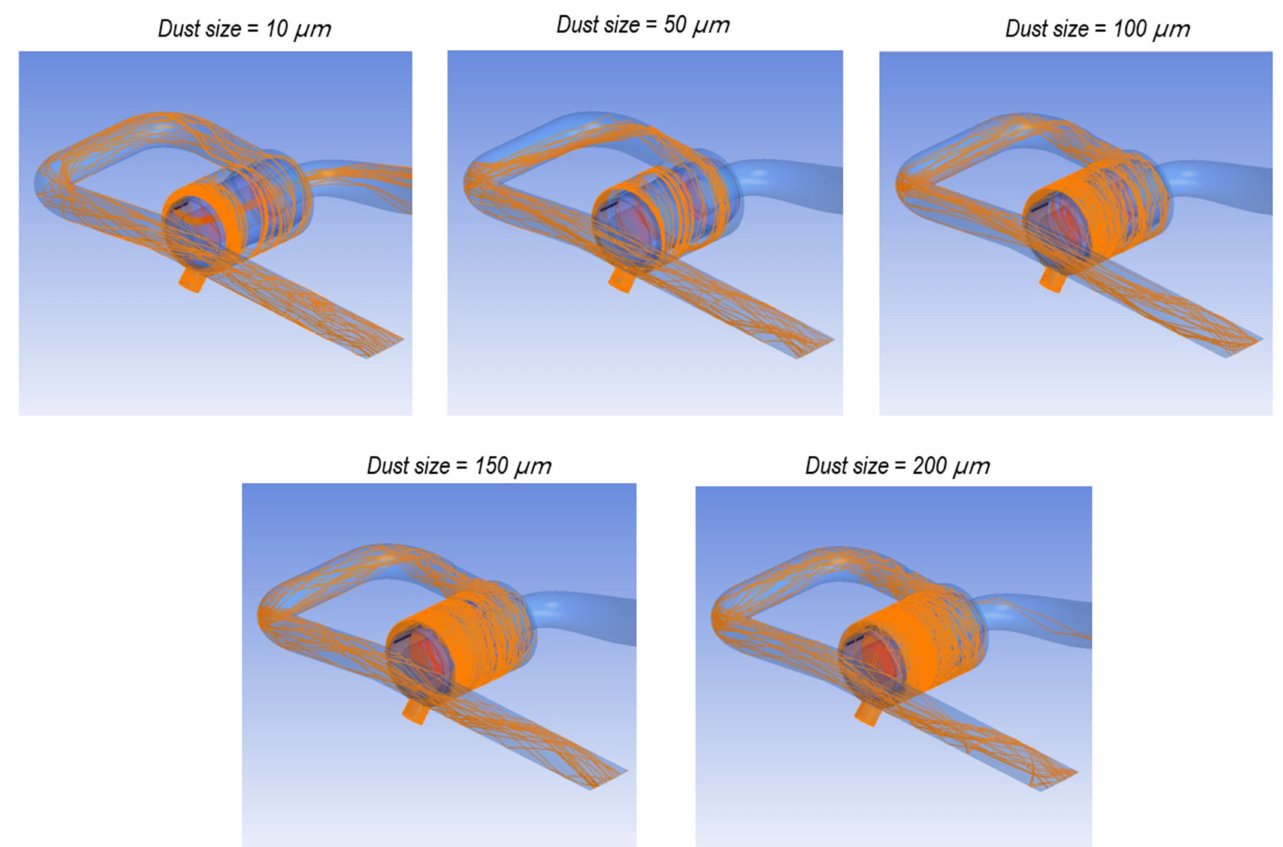
Figure 8. Dust traces in intake system at 4500 rpm condition, where α = 30 ◦ and β = 60 ◦